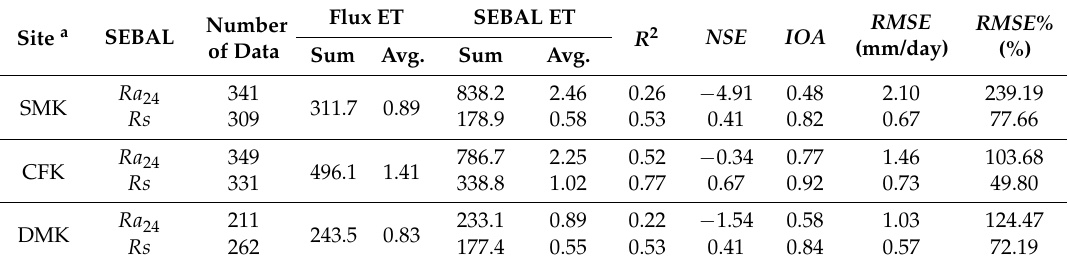
Table 2. Comparison SEBAL results of Ra 24 and Rs ET at three flux tower locations in